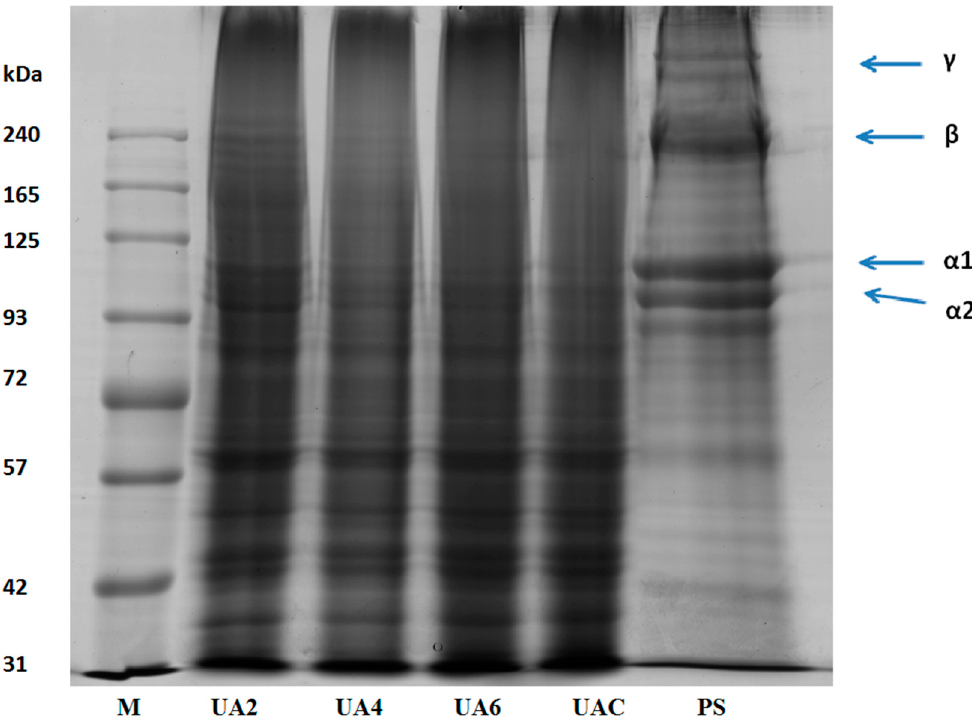
Figure 1. SDS-PAGE pattern of pretreated hide (PS) sample along with gelatin extracted using ultrasound for the time duration of 2, 4 and 6 h (UA2, UA4 and UA6, respectively) from bovine hide with actinidin pretreatment. UAC: control gelatin extracted using ultrasound without enzyme pretreatment. M denotes the marker.